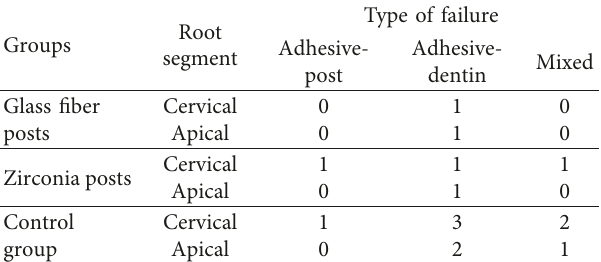
Table 4: Type of failure modes in each group.